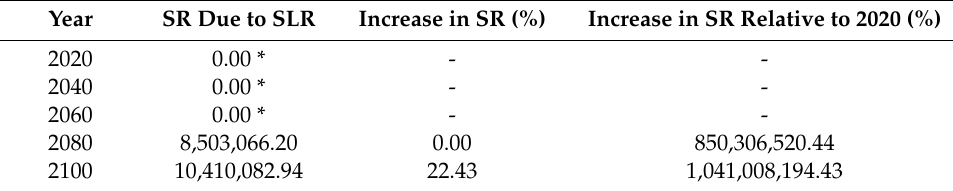
Table 9. Social risks (SR) at Cairo due to Sea Level Rise (SLR).